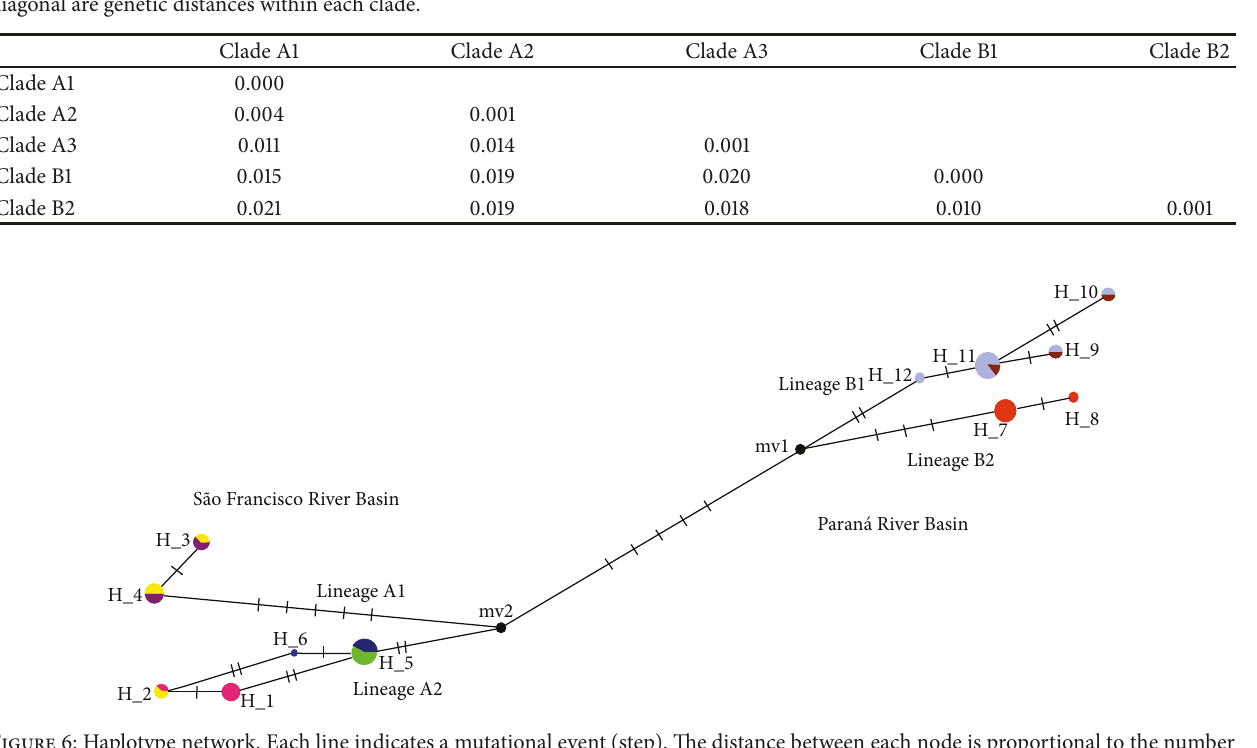
Figure 6: Haplotype network. Each line indicates a mutational event (step). The distance between each node is proportional to the number of mutational steps. The black circles are the missing haplotypes. Sampled populations: 1, Borrachudo River (yellow); 2, Tiros Stream (pink); 3, Vereda Grande stream (light green); 4, Do Boi River (dark blue); 5, Abaet´e river (purple); 6, ´Agua Grande stream (brown); 7, Parana´ıba river (light blue); 8, S˜ao Jo˜ao river